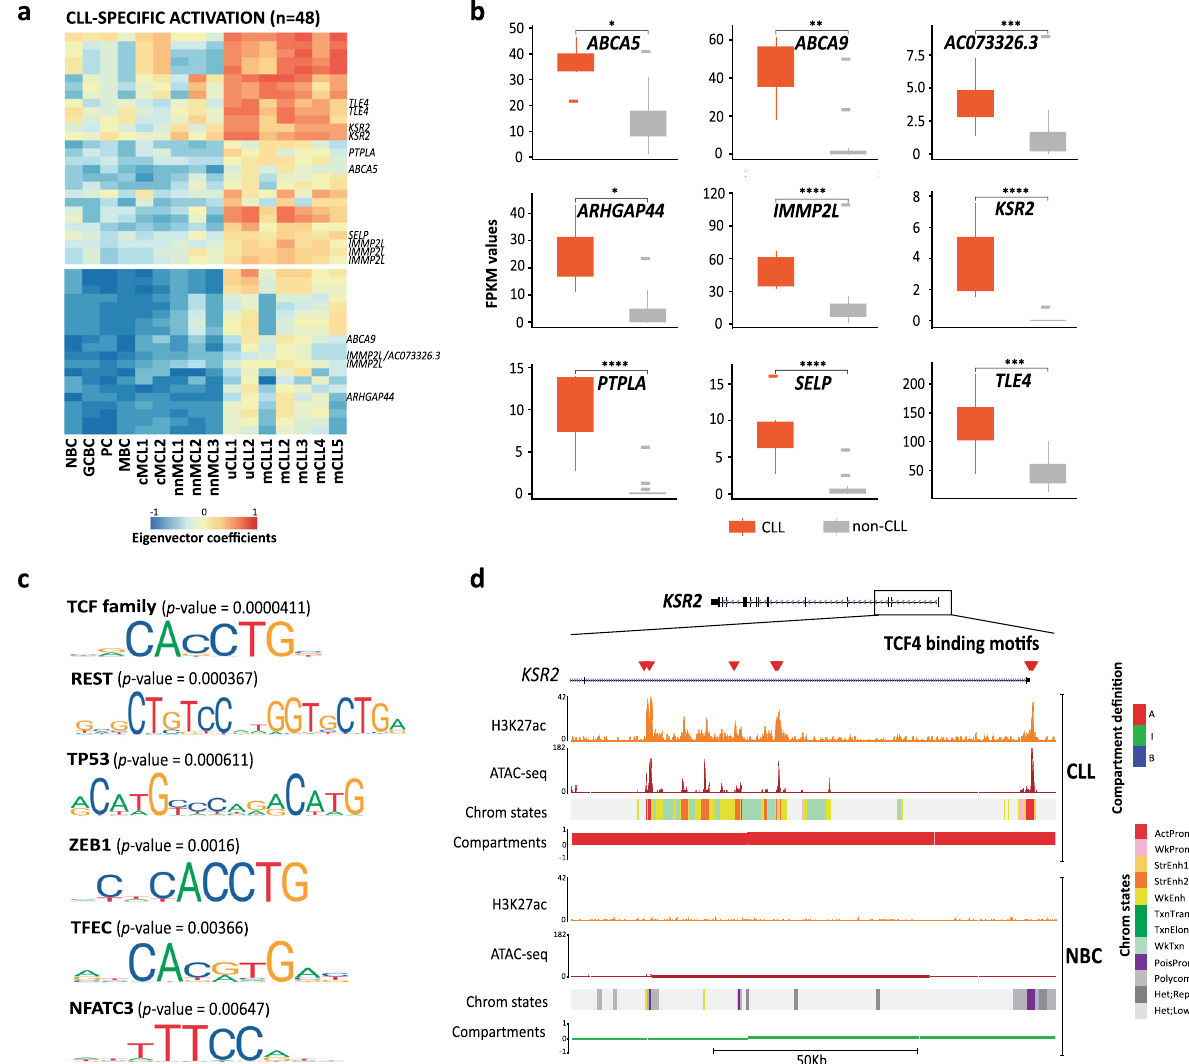
Fig. 6 Transcription factors associated with CLL-speci fi c activated compartments. a Heatmap showing the fi rst eigenvector coef fi cients of the compartments gaining activation speci fi cally in CLL ( n = 48). Signi fi cantly upregulated genes (FDR < 0.05) associated with each compartment are shown on the right of the heatmap. b FPKM values of all the CLL-speci fi c signi fi cantly upregulated genes within compartments gaining activation. c Enrichment analysis of transcription factor (TF) binding motifs. The most signi fi cant TF binding motifs enriched inactive and accessible loci within the CLL-speci fi c regions gaining activity ( n = 25 independent genomic loci) vs. the background ( n = 28 independent genomic loci). P values were calculated using the Wilcoxon rank-sum test (one-sided). d Example of TCF4 binding motifs at the KSR2 promoter region in CLL and NBC. The H3K27ac ChIP-seq signal, chromatin accessibility (ATAC-seq) and chromatin states of a representative NBC replicate and CLL sample are shown. The coordinates of the represented region are chr12:117,856,977 – 117,975,164, GRCh38. Sample sizes were for CLL: n = 7 biologically independent samples and for non-CLL: n = 17 biologically independent samples ( n = 3 for each NBC, GCBC, PC, and MBC, n = 5 for MCL cases). For the boxplots, centerline, box limits, and whiskers represent the median, 25th, and 75th percentiles and 1.5× interquartile range, respectively. The comparison was performed using the Wilcoxon rank-sum test (two- sided). *adjusted p value < 0.05, **adjusted p value < 0.01, ***adjusted p value < 0.001, ****adjusted p value <